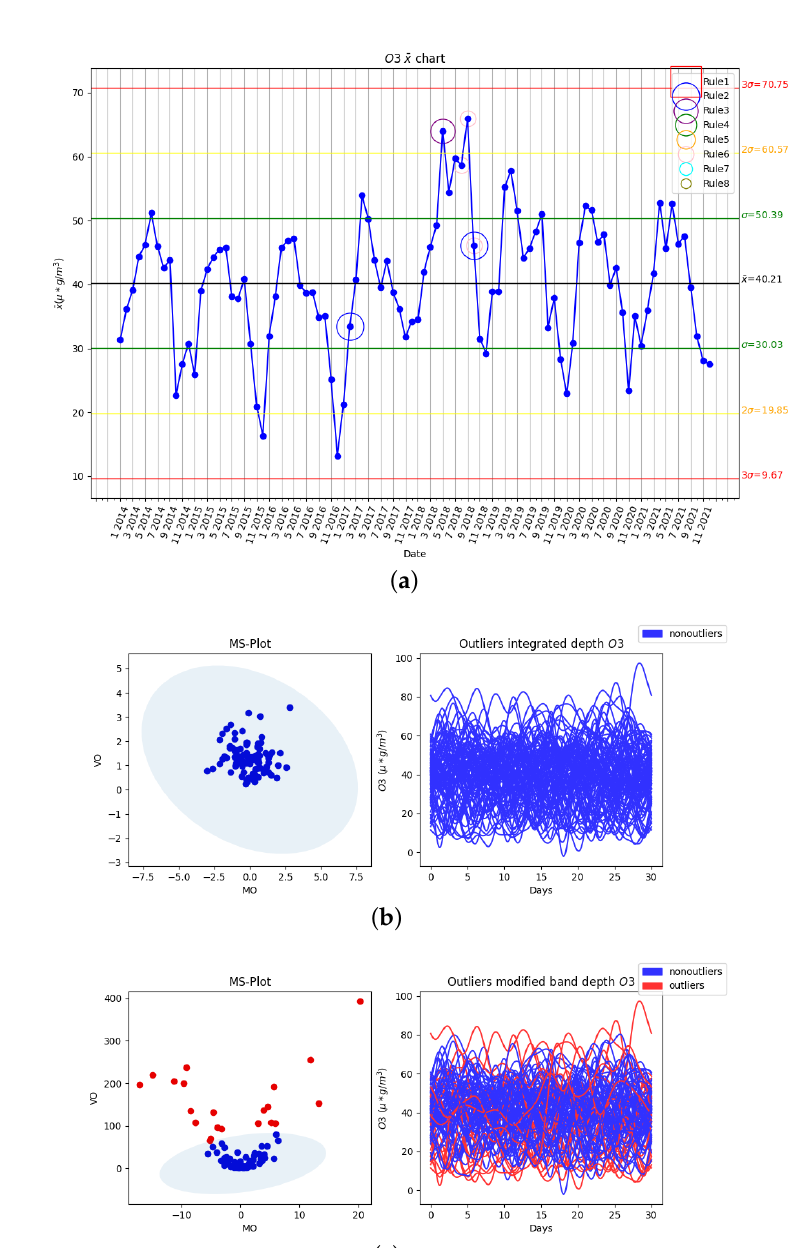
Figure 9. Results of the second phase of the O 3 analysis: ( a ) ¯ x chart with the monthly rational subgroups and the Nelson rules implemented; ( b ) (left) Cartesian representation of the magnitude and shape outlyingness of each function with the integrated depth; (right) functional plot of the O 3 values of each month; ( c ) (left) Cartesian representation of the magnitude and shape outlyingness of each function with the modified band depth; (right) functional plot of the O 3 values of each